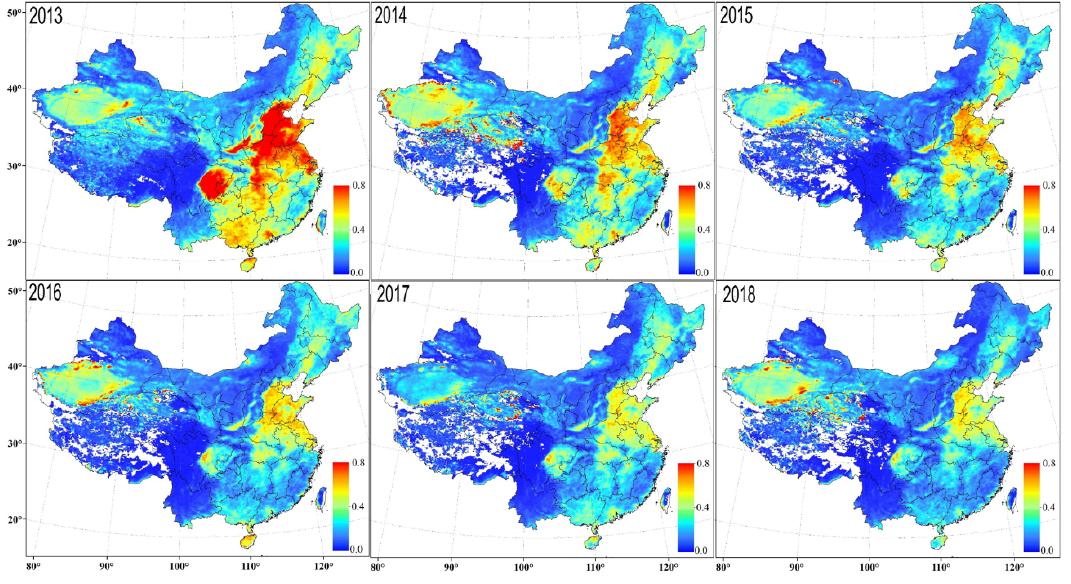
Figure 4. Temporal variations of monthly AERONET AOD.